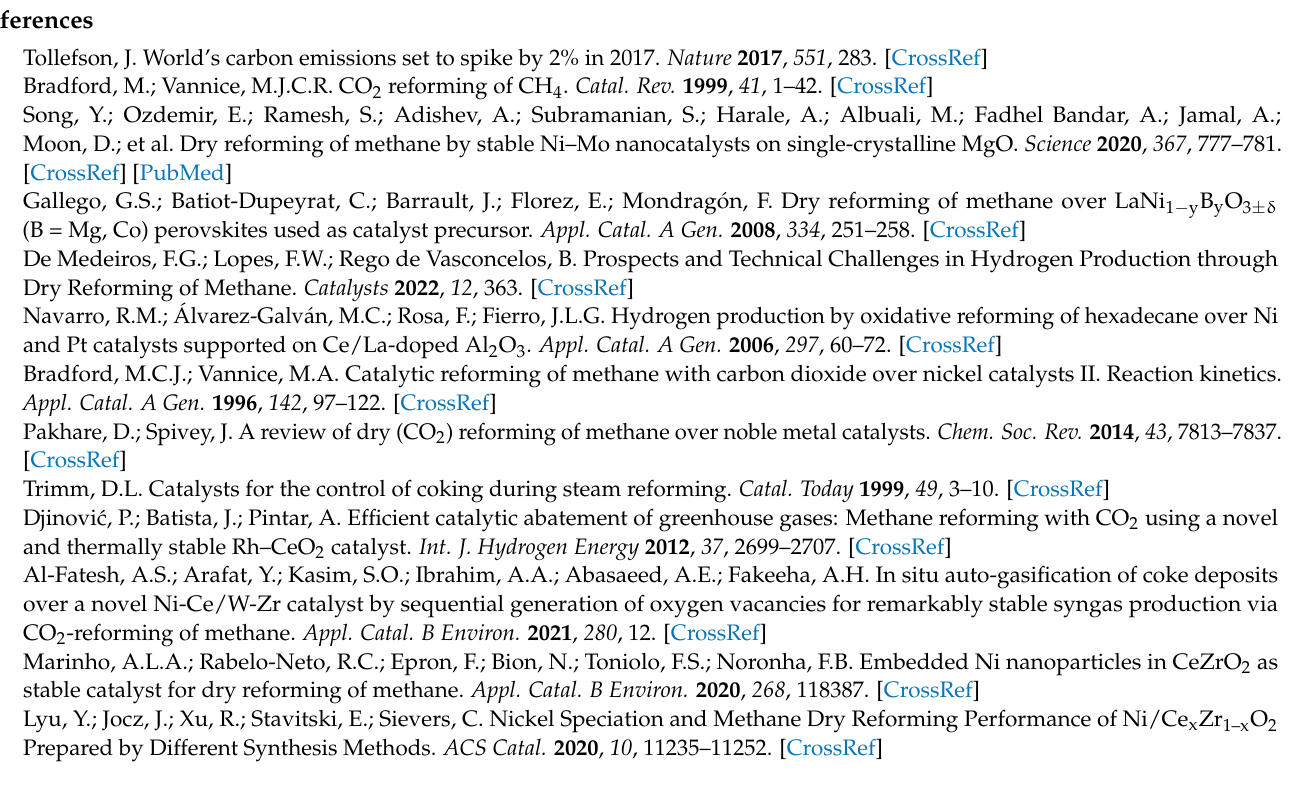
conversion during 50 h, and (c) H 2 /CO ratio during 50 h of the blank tube and pure CeO 2 support with different preparation methods. Figure S3. Apparent activation for: (a) CO 2 and (b) CH 4 of CeO 2 -C and CeO 2 -M catalysts. Table S1. Comparisons of TOF for typical Ni-based catalysts. Figure S4. (a) CO 2 -TPSR profile; and (b) CH 4 -TPSR profile of CeO 2 -C and CeO 2 -M. Figure S5. Linear combination fitting (LCF) of XANES spectra for the reduced catalysts. Figure S6. Scheme picture of microimpinging stream reactor system. Figure S7. Photo and structure of the mini T-junction. Table S2. Details of the microimpinging stream reactor system. Figure S8. Schematic diagram of two-step transient surface reaction. Figure S9. Diagrammatic sketch of the tube with values at the ends. Figure S10. (a) CO 2 conversion (b) CH 4 conversion, and (c) H 2 /CO ratio of Ni/CeO 2 -B